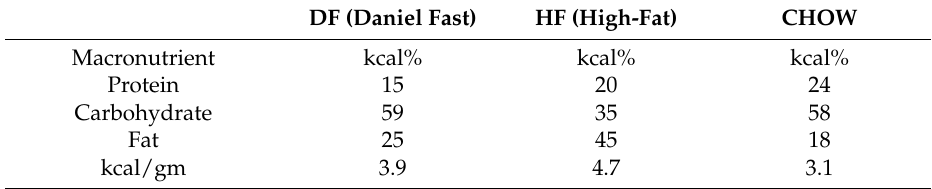
Table 1. Macronutrient composition and caloric density of experimental diets.